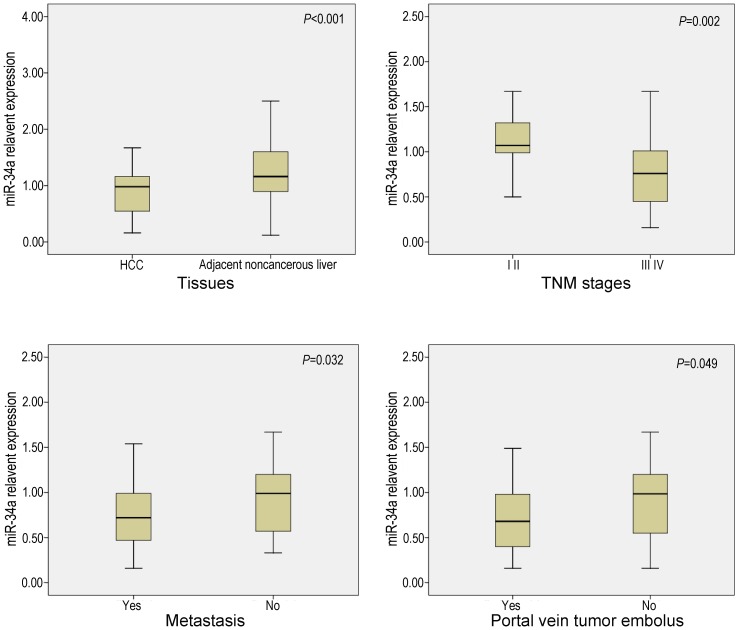
Relationship between miR-34a expression and clinicopathological parameters. miR-34a expression was determined using real time RT-qPCR.